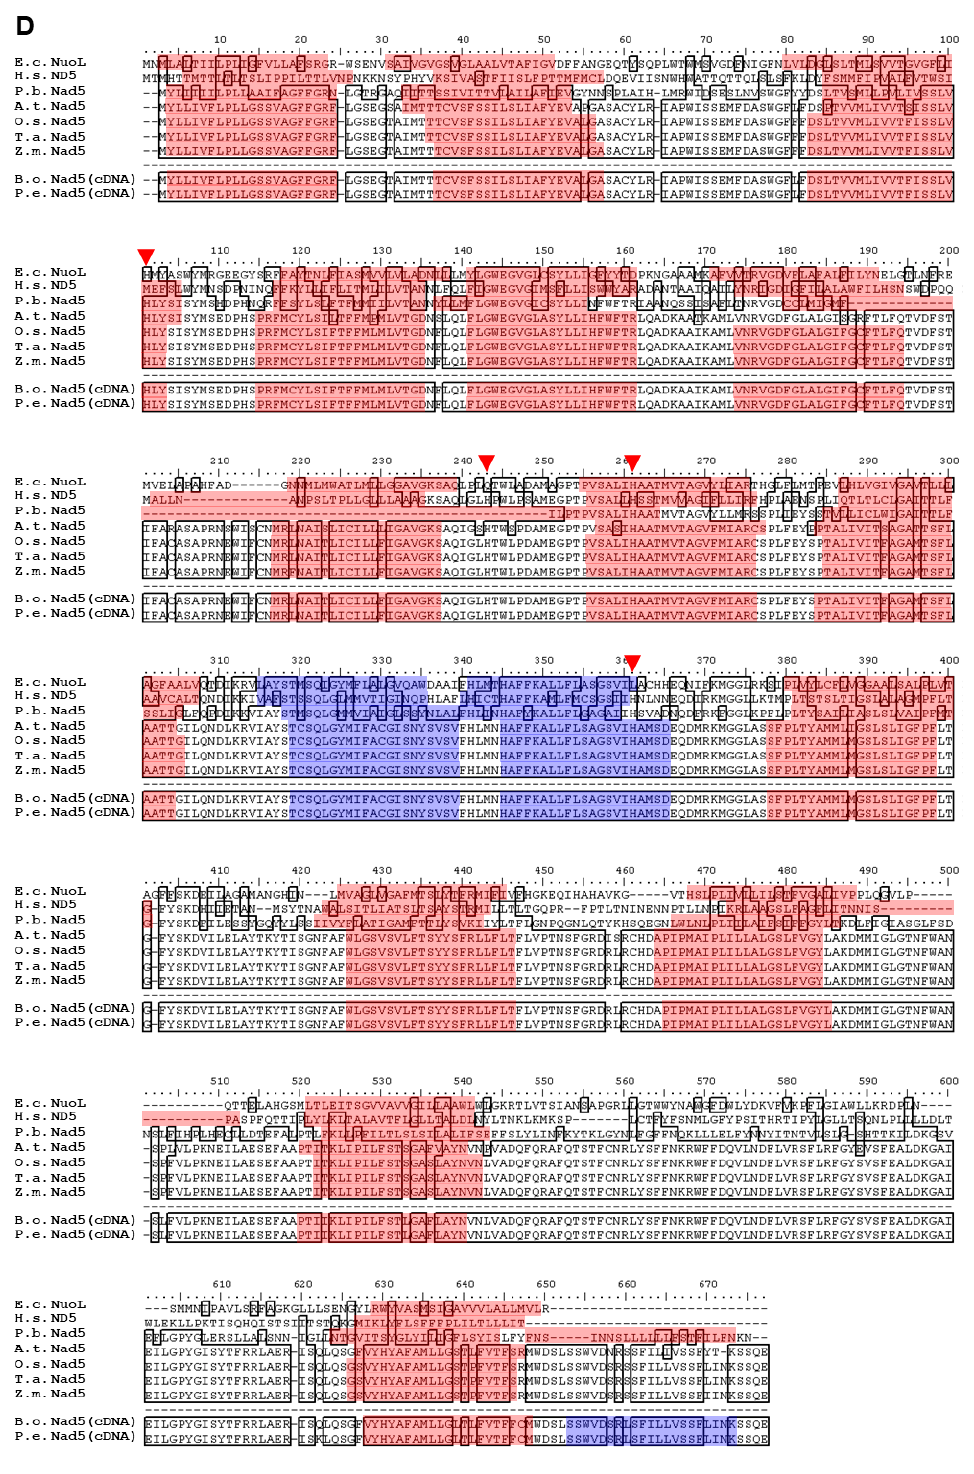
Figure 1. Comparison of bamboo mitochondrial Nad1, Nad2, Nad4, and Nad5 amino acid sequences with the homologous proteins in other species. The polypeptide sequences of Nad1 ( A ), Nad2 ( B ), Nad4 ( C ), and Nad5 ( D ) translated from the cDNA of B. oldhamii (B.o.; ABZ79354, KF219802, ABZ79355, and ABZ79356) and Nad1, Nad4, and Nad5 from that of P. edulis (P.e.; ABV68729, ABZ79357, and ABZ79358) compared with those of their homologs from E. coli (E.c.; BAA16110, BAA16113, BAA16105, and BAA16106), H. sapiens (H.s.; AAB58943, AAB58944, AAB58952, and AAB58953), P. brasiliensis (P.b.; AAY30326, AAY30327, AAY30329, and AAY30339), A. thaliana (A.t.; CAA69811, CAA69771, CAA69742, and CAA69752), O. sativa (O.s.; AAZ99270,